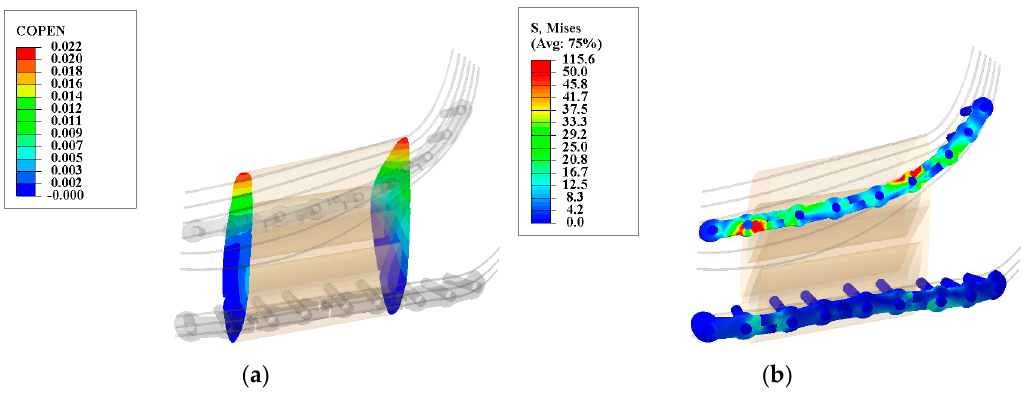
Figure 11. Deformation map for the graft/mandible junction ( a ) and von Mises stress distribution along the releasable Ti-6Al-4V hardware ( b ) in the second stage. The observed gap is less than the allowable gap (200–400 μ m) and the maximum observed von Mises stresses are less than their yielding points (superior hardware: 1186.8 MPa, and inferior hardware: 1098.6 MPa). (Units: micron ( μ m) and megapascal (MPa)).